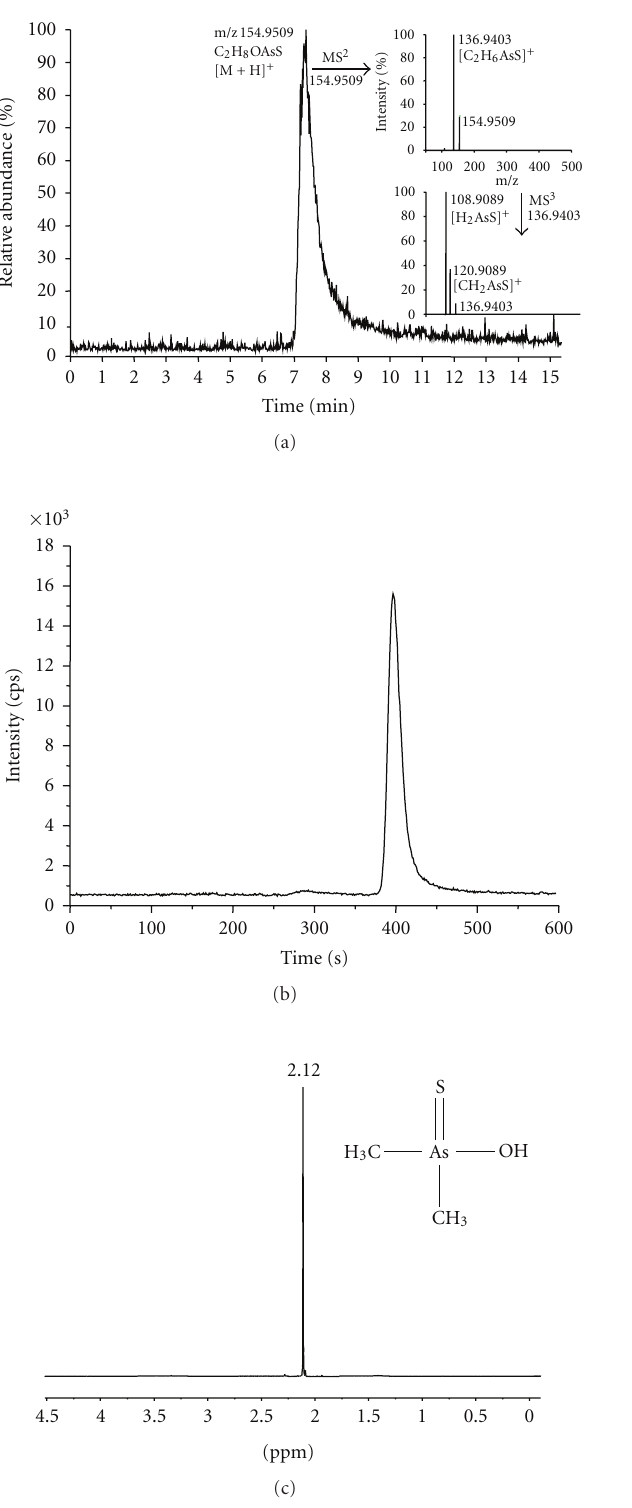
Figure 2: Analytical characterization of thio-DMA V . (a): HPLC- FTMS total ion chromatogram including fragmentation spectra of the parent ion m/z 154.9509 [C 2 H 8 OAsS] + ; (b): HPLC-ICPMS chromatogram selectively monitoring m/z 75 (As); (c): 1 H-NMR spectrum of thio-DMA V in D 2 O.